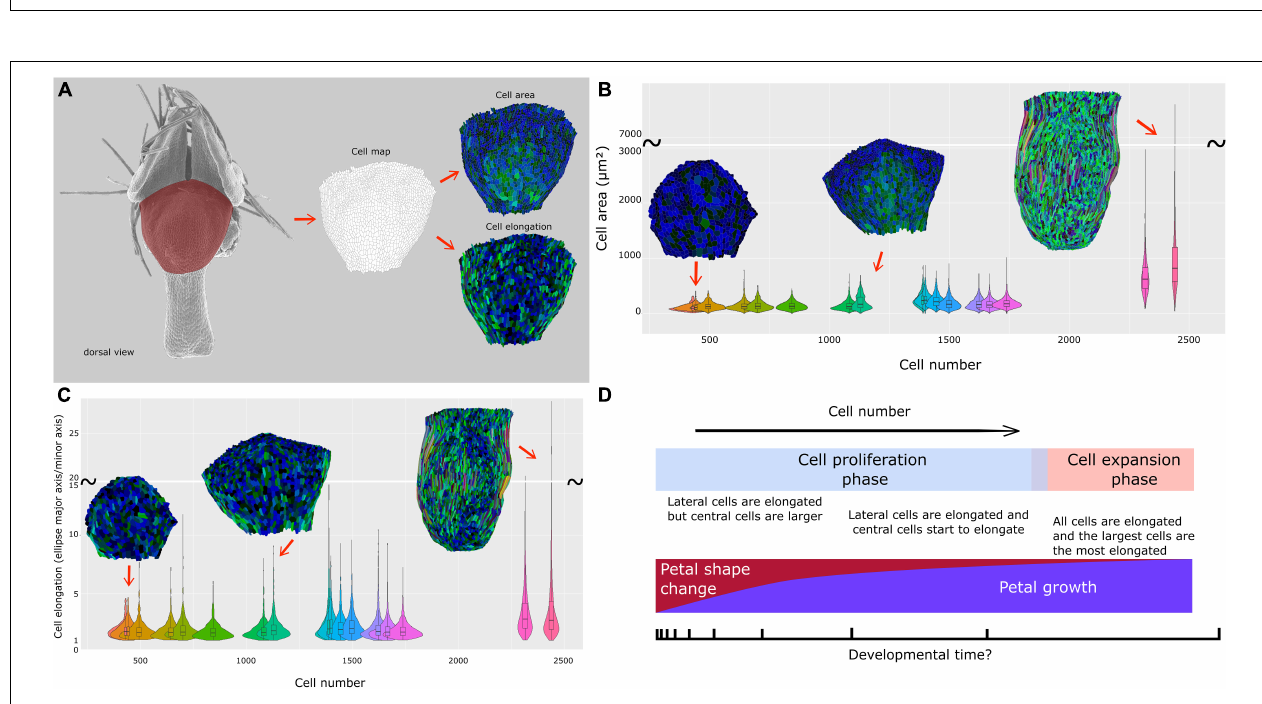
FIGURE 5 | Cell dynamics during petal morphogenesis with focus on a dorsal view of the nectar pouch. (A) The petal dorsal view of the nectar pouch has been transformed into cell maps to measure and visualize cell area (up) and cell expansion (down) dynamics. Color code is detailed in Supplementary Figure 1 . Dynamics and distribution of cell area (B) and elongation (major axis/minor axis of the equivalent ellipse) (C) are visualized through violin plots, themselves plotted against total cell number. (D) Summary of macroscopic and cellular characteristics of N. damascena petal during development.